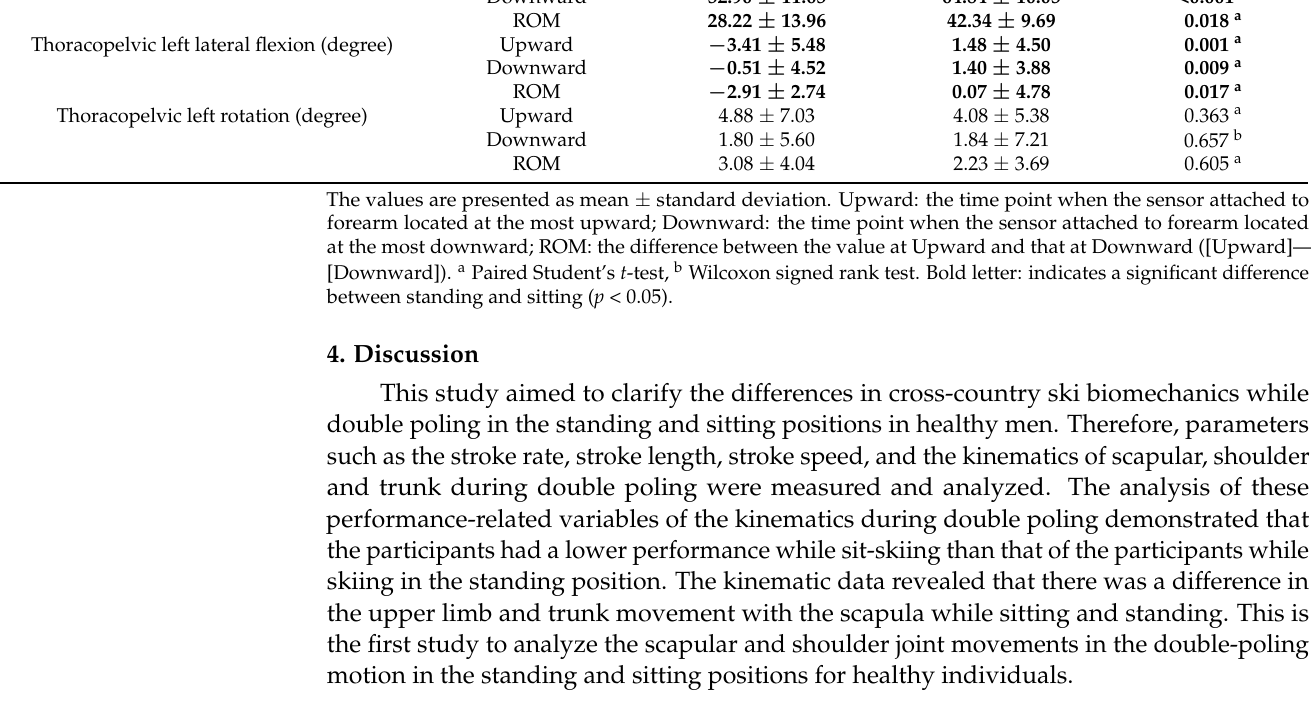
Table 3. The kinematic data of thoracopelvis during double poling in each position.